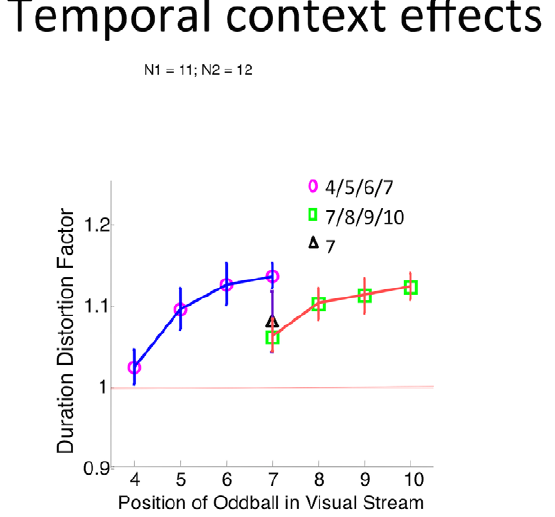
Figure 3. The oddball effect is subject to experimental context. (A) The oddball effect at the 7 th position was tested in 3 different blocks – among interleaved trials in which the oddball appears between the 4 th and 7 th position, interleaved trials in which the oddball appears between the 7 th and 10 th position, and trials in which the oddball only appeared at the 7 th position. (B) The size of the oddball effect when the oddball appears at the 7 th position is different depending on the expectations within the experimental block of